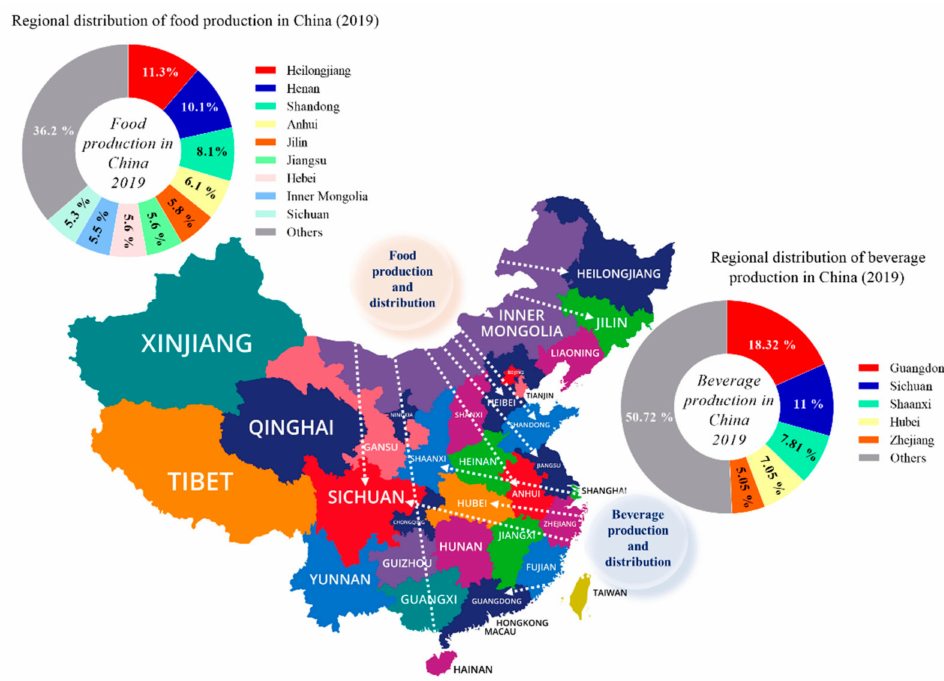
Figure 5. Regional distribution of food and beverage manufacturing industries in China. The major beverage production industries and their distributions are from the Guang- dong province, ranking topmost by contributing 18.32% of the total share of beverage production in China, followed by Sichuan 11%, Shaanxi 7.81%, Hubei 7.05%, Zhejiang 5.05%, and others 50.72% in 2019, respectively (Figure